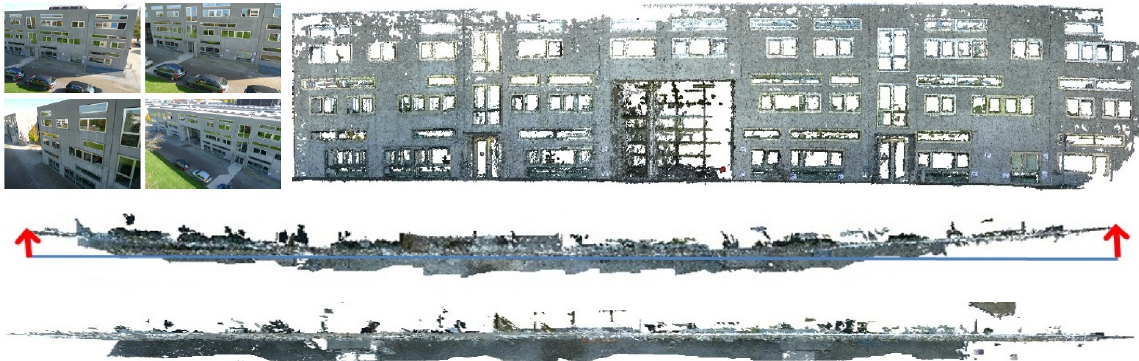
Figure 3: In the facade reconstruction using OpenCV calibration significant bending is prevalent (middle). In contrast, accurate camera parameters delivered by the method from (Daftry et al., 2013) results in a straight facade reconstruction (bottom). attempts to minimize the reprojection error of extracted feature points based on homographies between the individual views. Af-